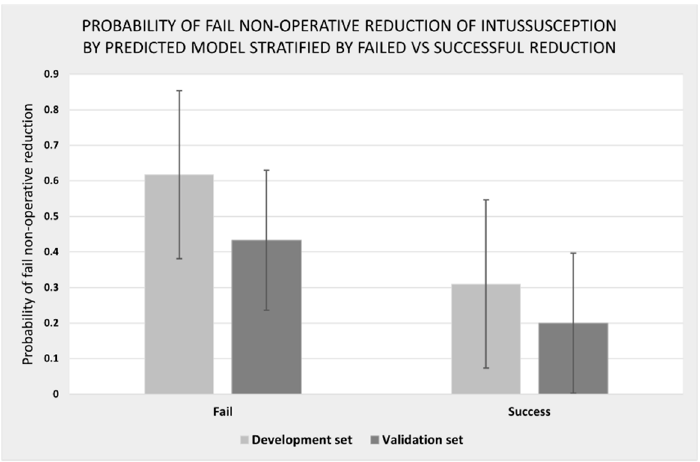
Figure 5. Calibration plots of the CMUI score in the development and validation sets. The dash lines at the cutoff point of 12 categorized patients with intussusception into low ‐ risk and high ‐ risk groups of failed non ‐ operative reduction.